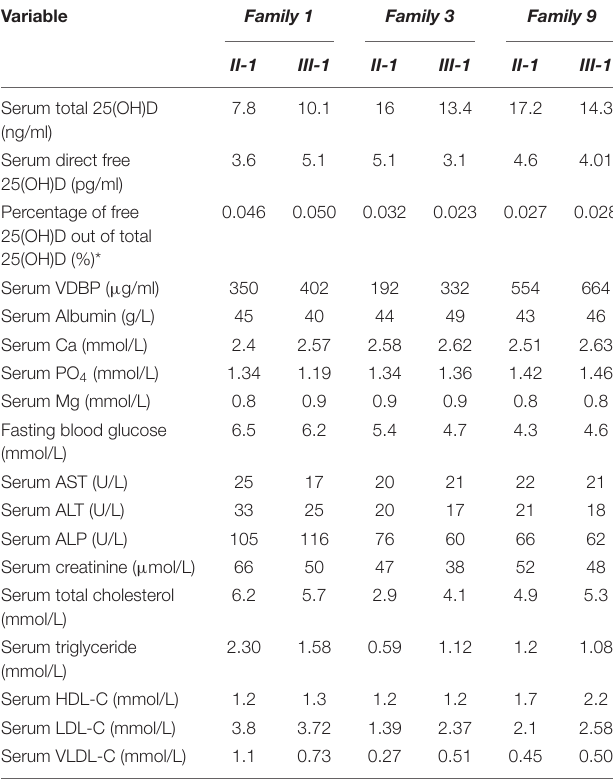
TABLE 3 | Biochemical characteristics of family 1, family 3, and family 9 female